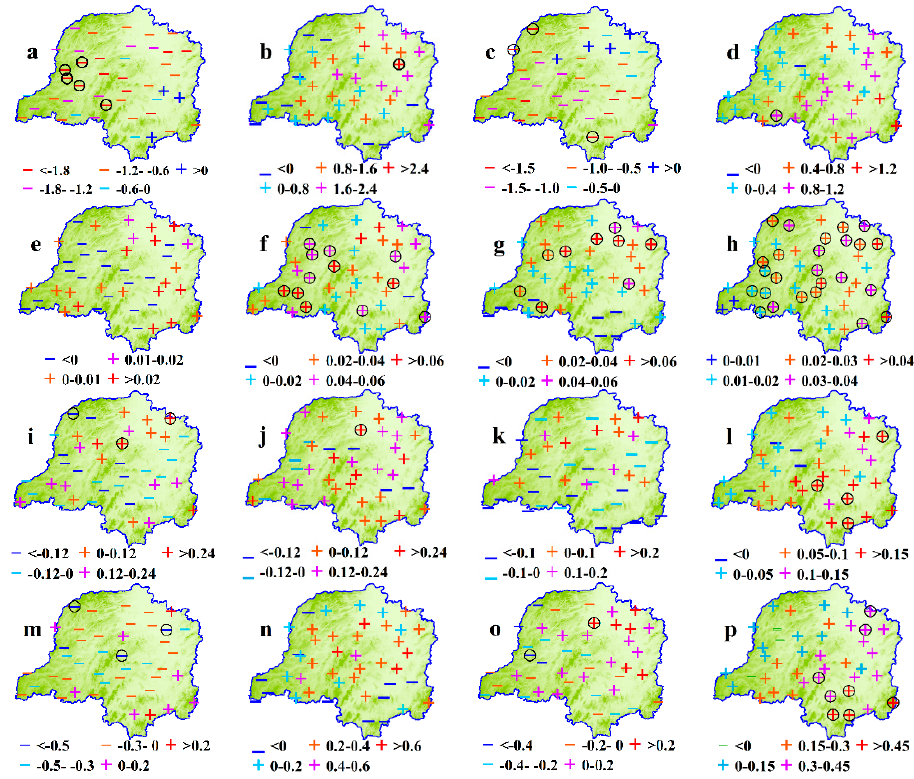
Figure 2. Trends for the four precipitation indices. ( a – d ): trends for total precipitation amount (R) in spring, summer, autumn and winter, respectively, and similarly ( e – p ) shows the trends for the Ri, Rx1 and Rx5 in the four seasons. The “+” and “ − ” represent increasing and decreasing trends, respectively, and the black circles indicate significance at p < 0.05.